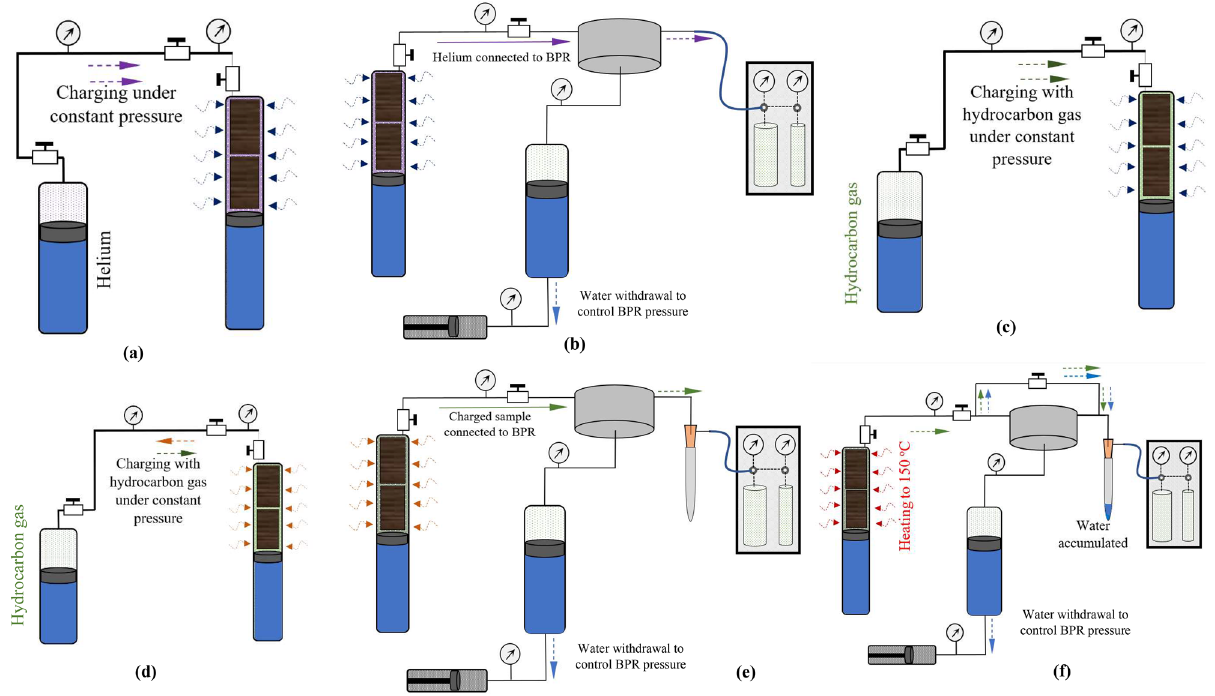
Figure 3. Experimental procedure of controlled decompression experiments for gas in place measurements: ( a ) helium calibration of pore- and dead-volumes under low-T; ( b ) measuring charged helium at low decompression rate; ( c ) charging with hydrocarbon at low-T; ( d ) applying reservoir temperature; ( e ) producing the hydrocarbon gas under core-lifting conditions; ( f ) heating up the core to 150 °C to measure gas and water. This last stage replicates the conventional canister